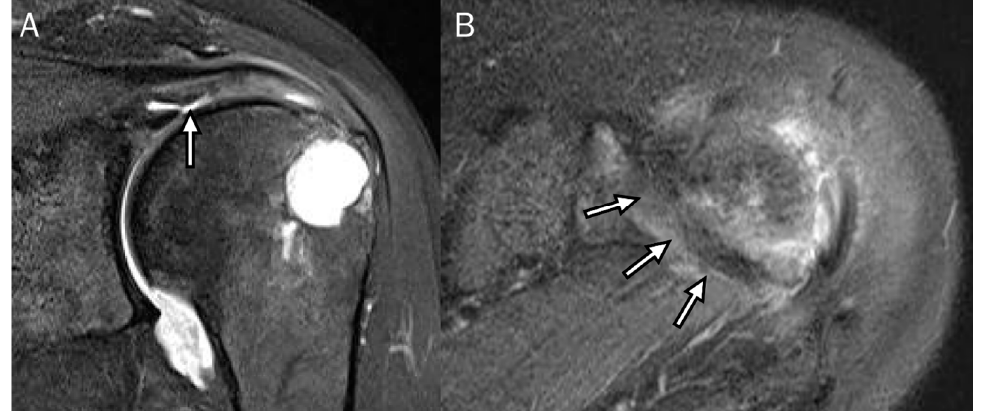
Figure 9. Articular-delaminated partial-thickness tear of the supraspinatus tendon with retraction (no visible cleavage). ( A ) Oblique coronal fat-suppressed T2-weighted image and ( B ) axial fat-suppressed T2-weighted image demonstrate an undersurface delaminated tear with subsequent retraction presenting as a retracted rotator cable (arrows).